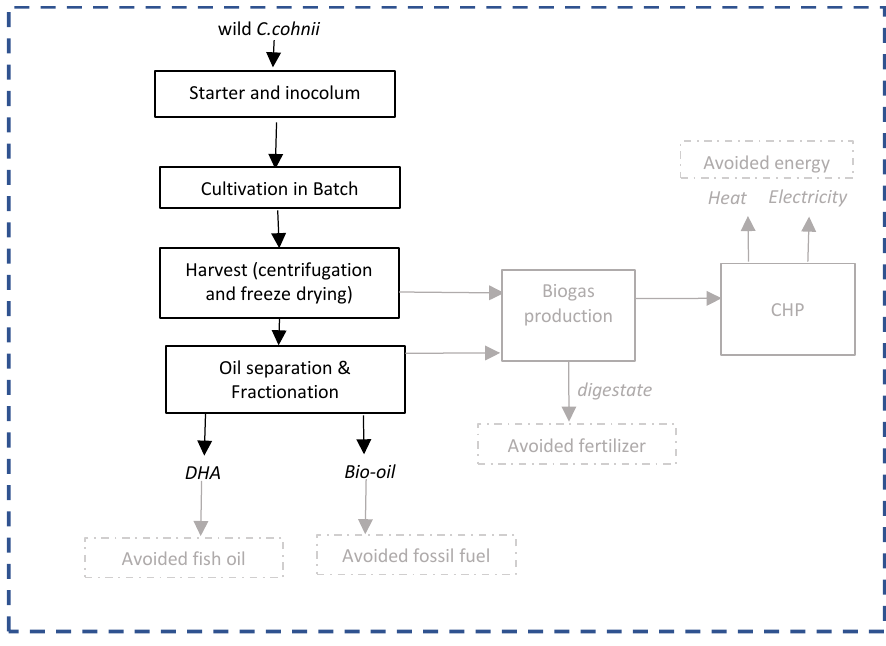
Figure 6. Cascading products scheme.